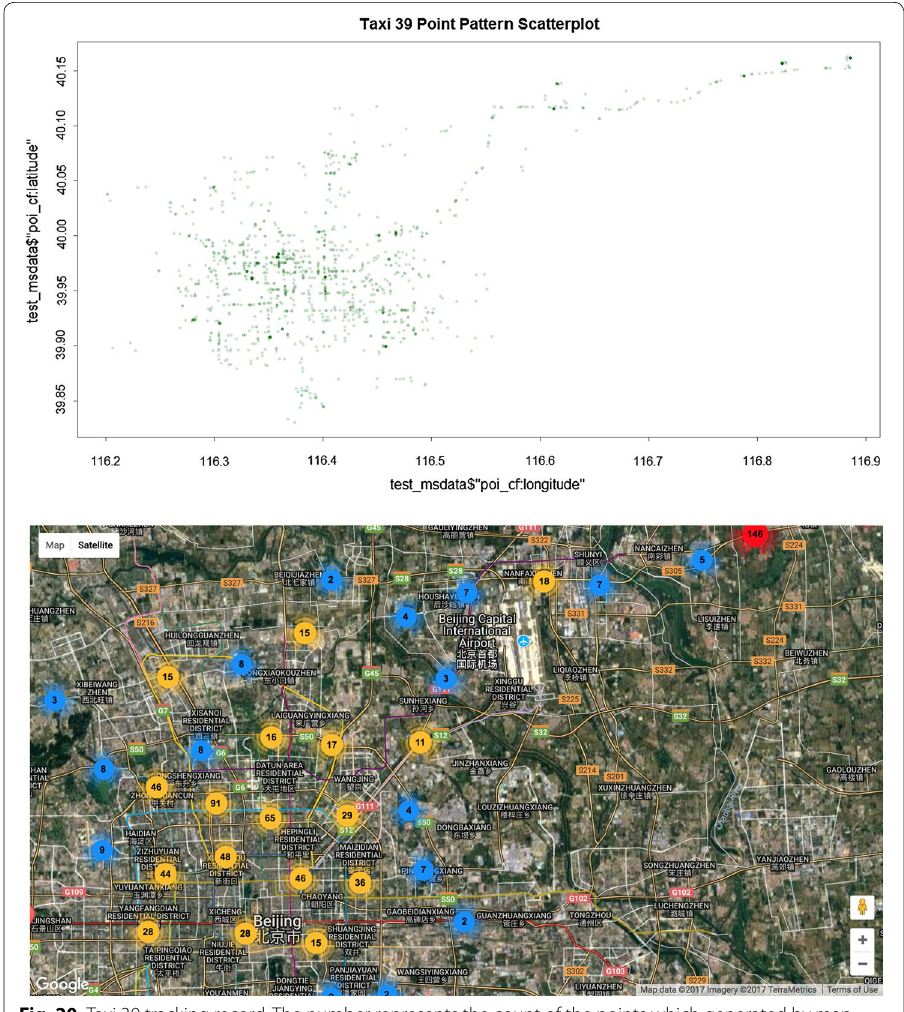
Fig. 20 Taxi 39 tracking record. The number represents the count of the points which generated by map